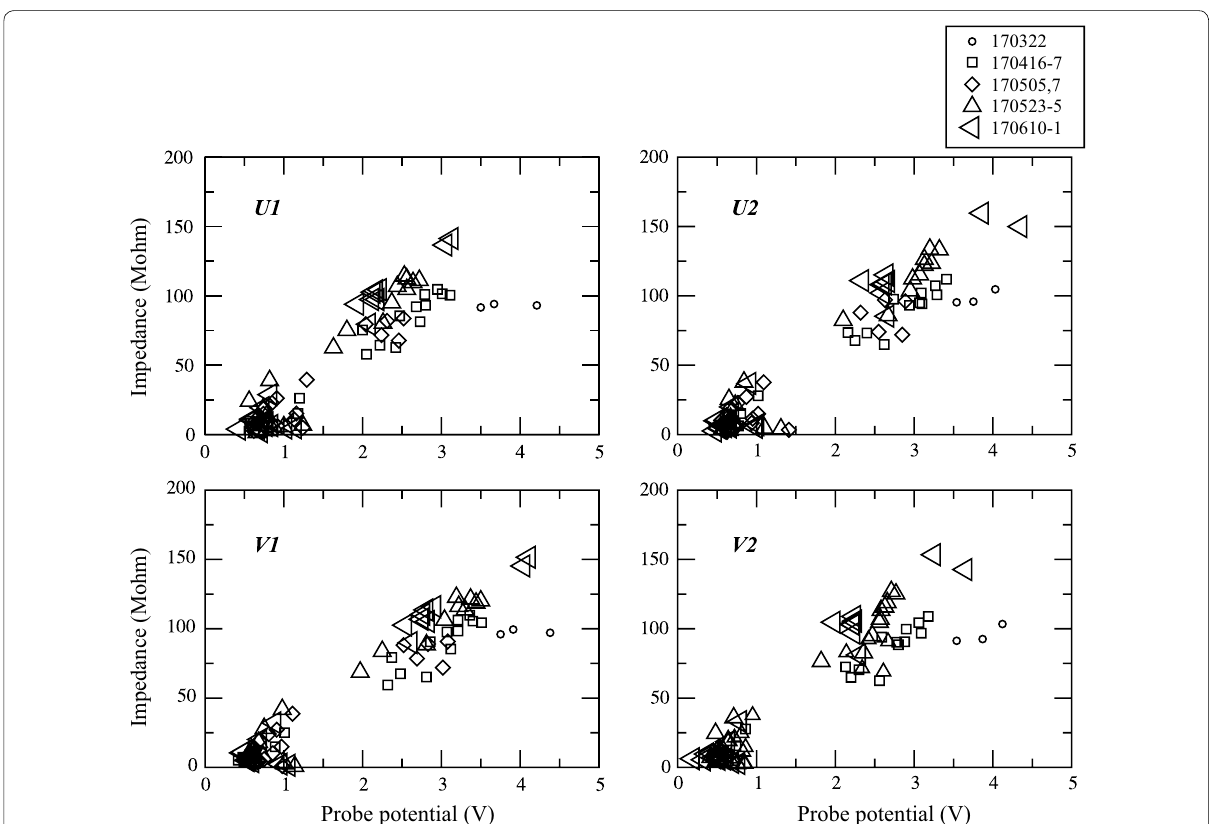
Fig. 9 Antenna resistance evaluated by the bias sweep operations during March–May 2017. X-axis indicates the floating probe potential (positive: lower density), and Y-axis indicates the estimated resistance. Each symbol shows the evaluated date by the bias current sweep operation: 170322,